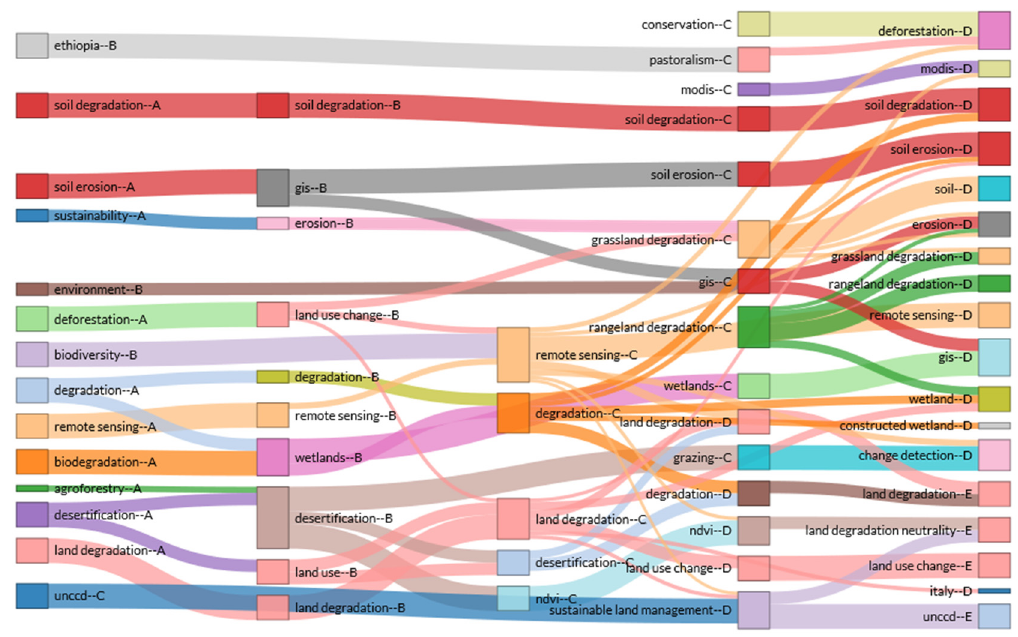
Figure 13. Thematic evolution of the land-degradation research (1990–2019).